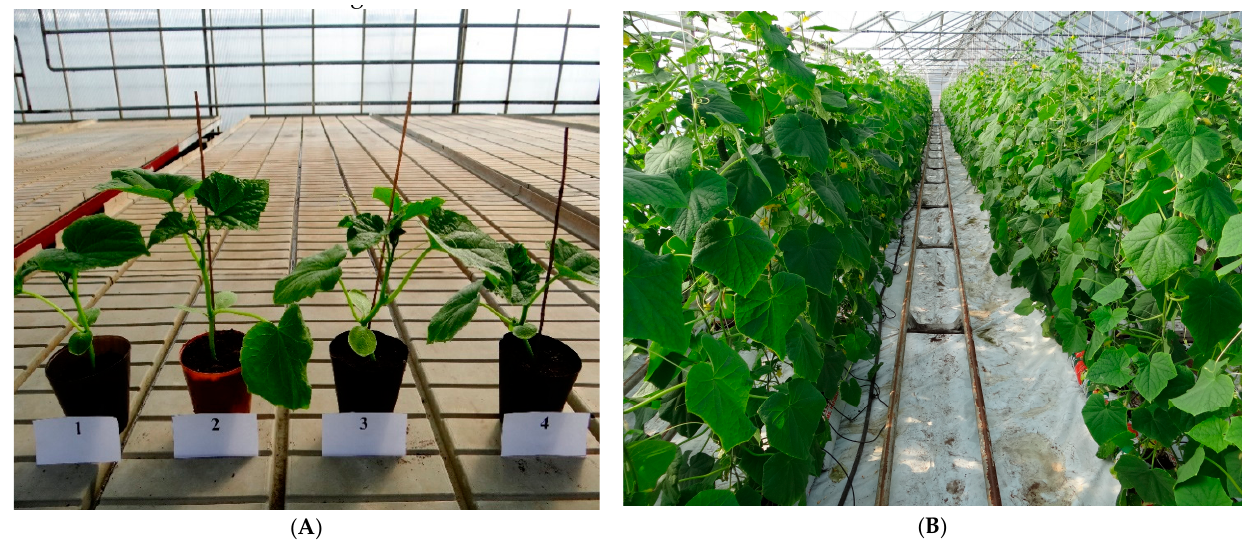
Figure 1. Cucumber seedlings grown in peat–vermicompost substrates (1—peat; 2—peat+10% vermicompost; 3—peat+20% vermicompost; 4—peat+30% vermicompost) ( A ), trial of cucumbers in the greenhouse ( B ).